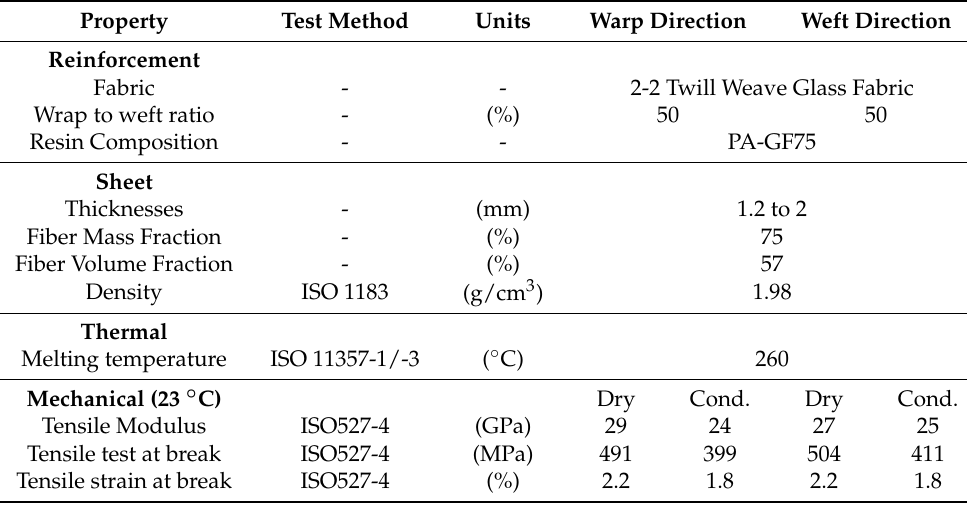
Table 1. DuPont-TM Vizilon™ SB75G1 thermoplastic composite